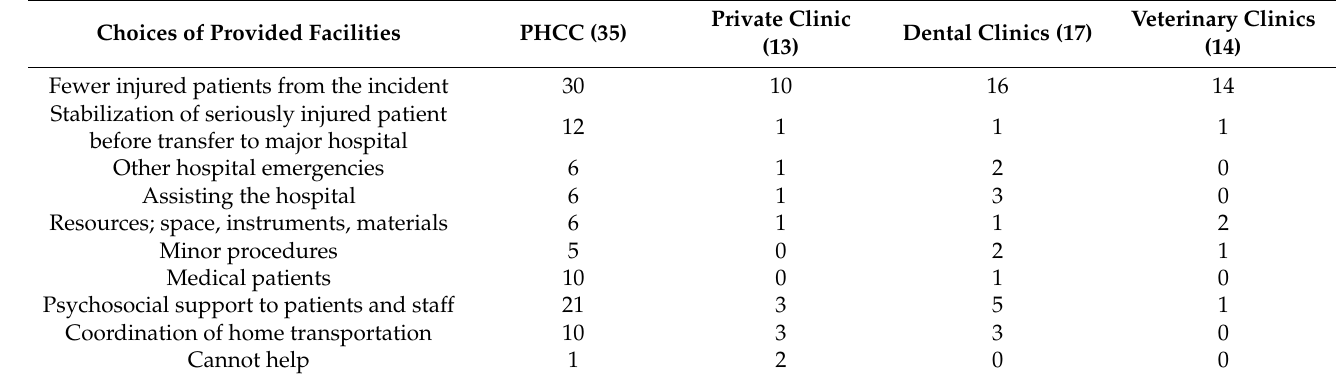
Table 2. Questionnaire data of potential support that clinics could